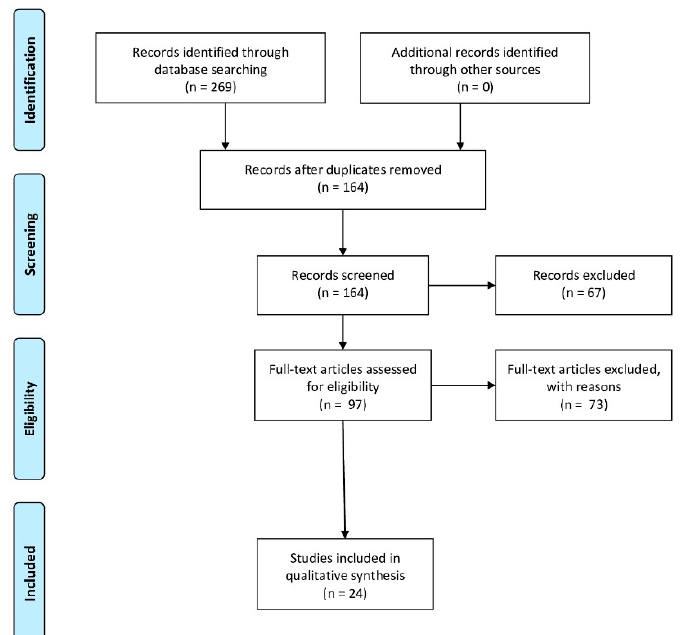
Figure 1. Prisma flow diagram illustrating the selection methodology of the preclinical studies used for the writing of the review. Duplicate articles were excluded from the total of the studies recorded. Instead, were considered articles that evaluate the damage of oxidative stress induced by fetal hypoxia (The PRISMA Statement was published in: [17] )